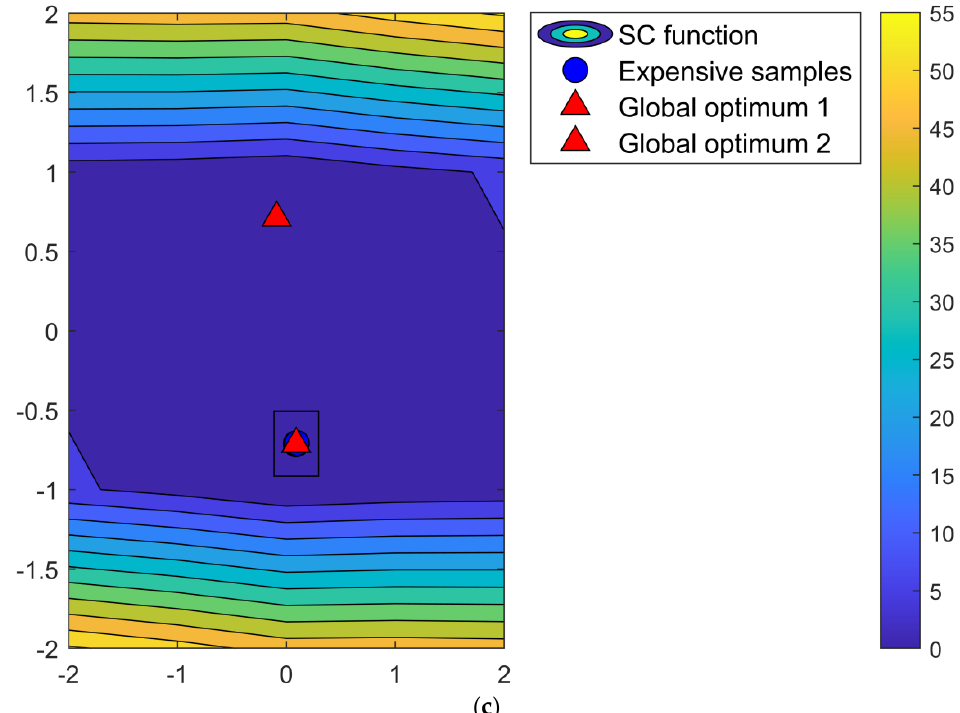
Figure 5. Evolution of the subspace (NIT = 9, 11, 13). ( a ) Subspace when NIT = 9. ( b ) Subspace when NIT = 11. ( c ) Subspace when NIT = 13.